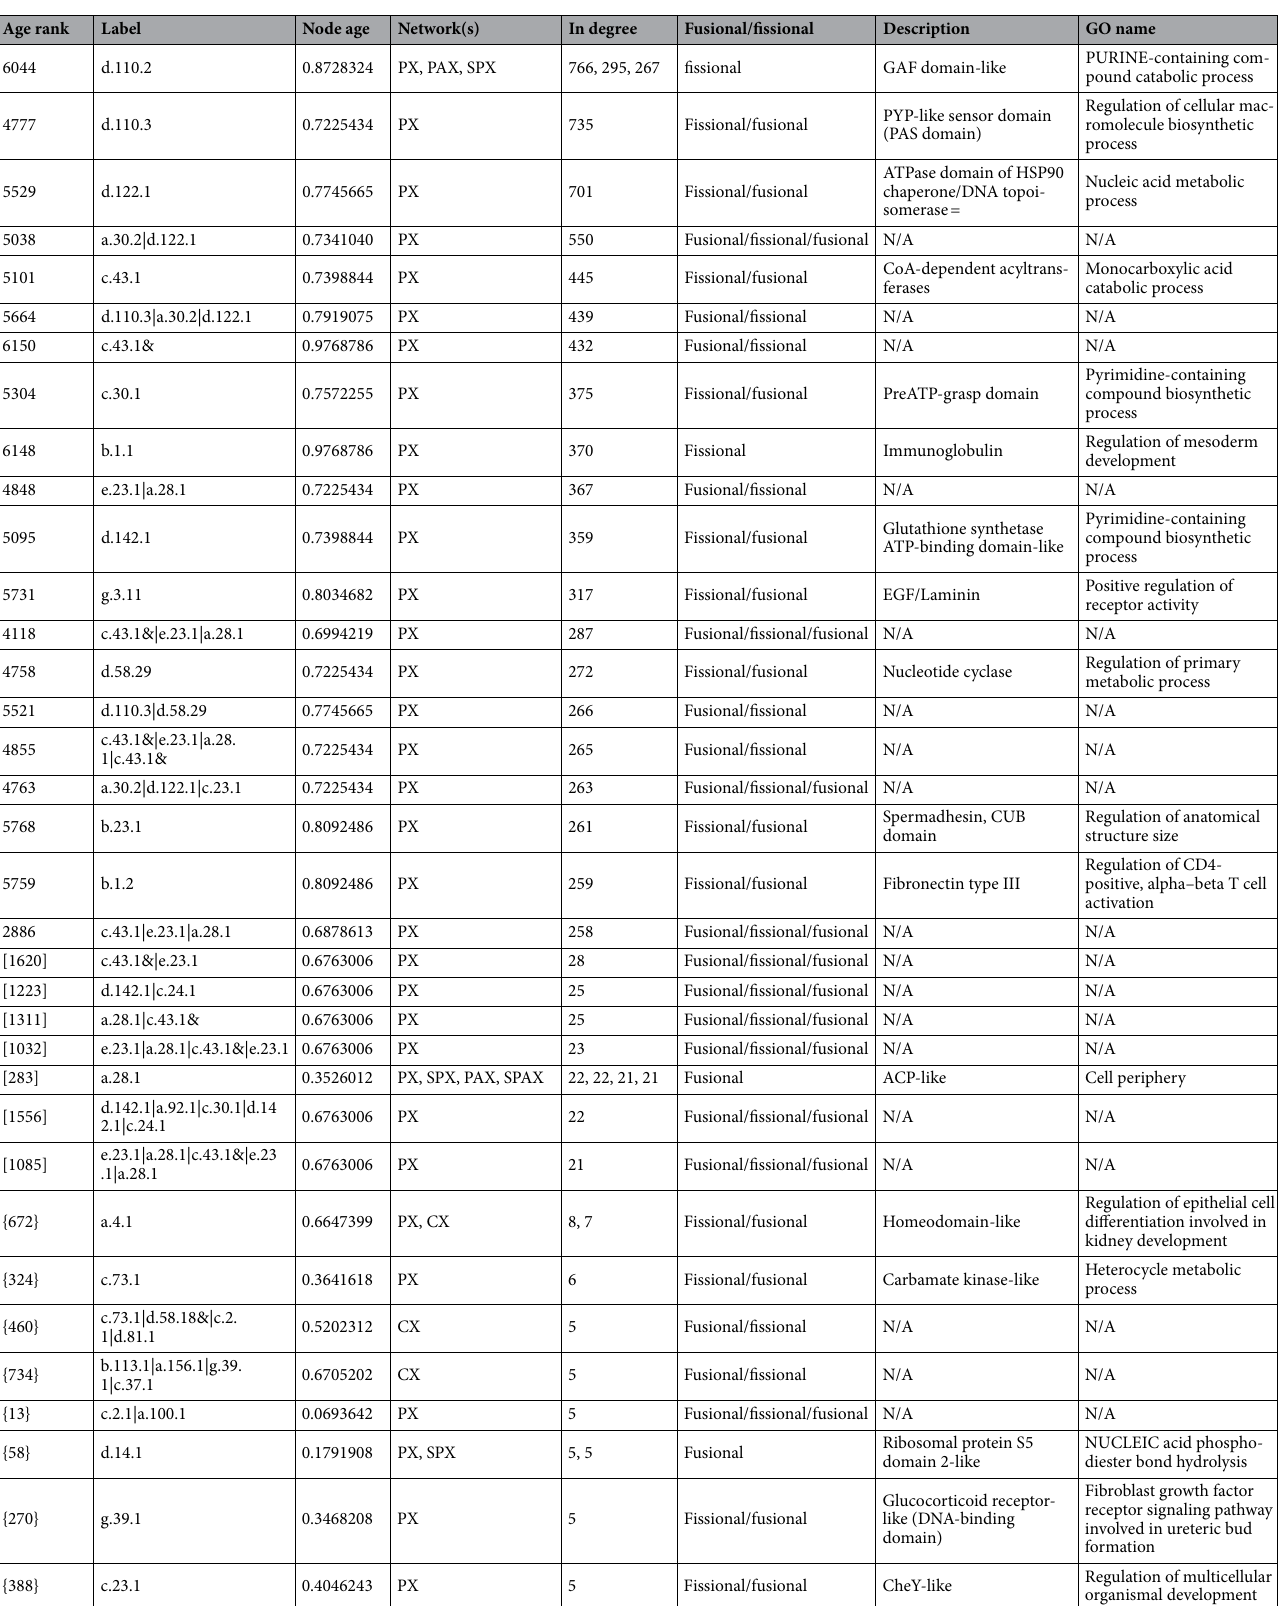
Table 2. Domains and domain combinations scoring > = 99.9th percentile of 247.977, [20] and {5}, based on combined in degrees of the five networks at time points 1.0, [0.676] and {0.671}, respectively. The square and curly brackets denote values from the events after and before the big bang, respectively. N/A, not